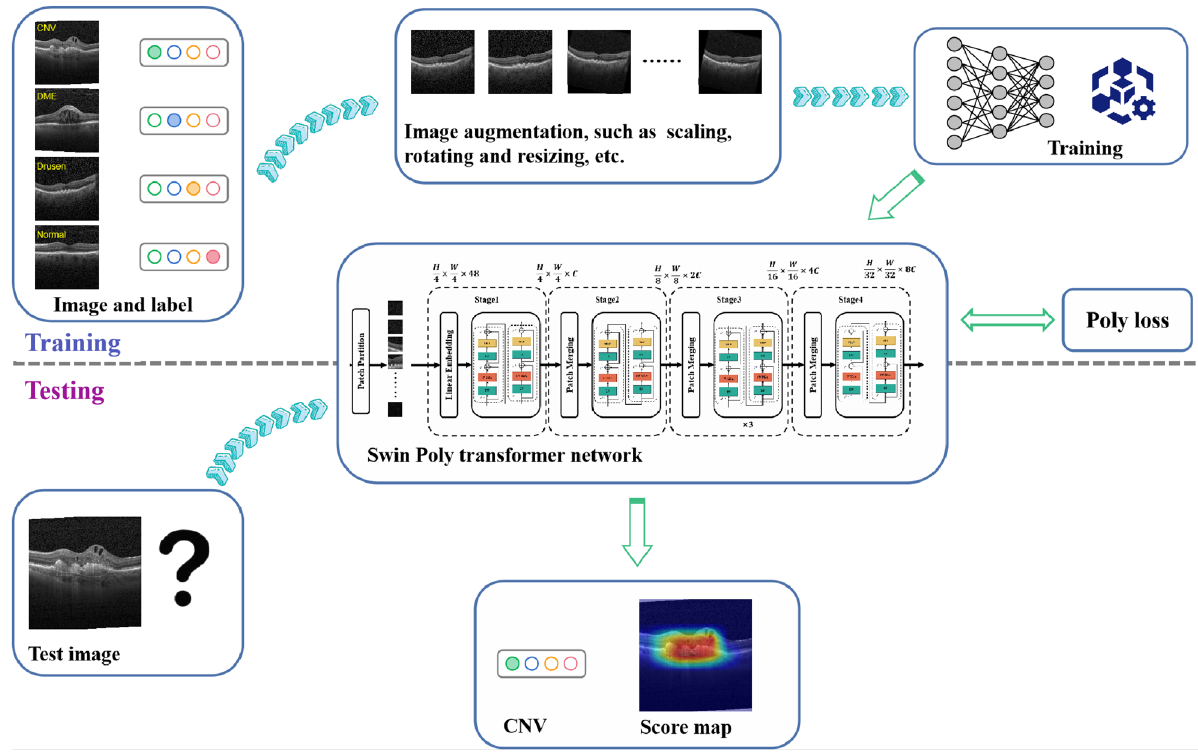
Figure 2. The overall framework of the proposed